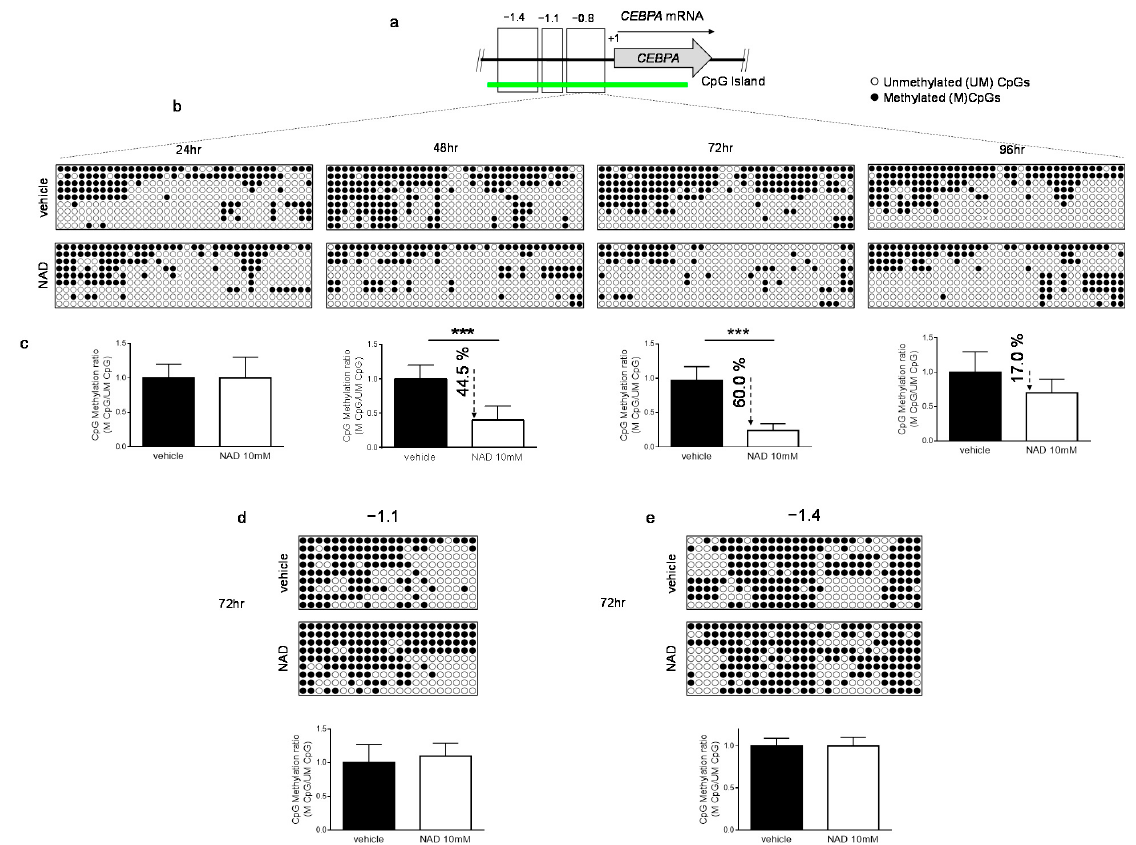
Figure 2. DNA methylation patterns of CEBPA upon NAD (10 mM) or vehicle treatment. ( a ) Schematic representation of CEBPA locus. The three regions analyzed in the promoter of CEBPA located at − 0.8 kb ( − 557; − 857), − 1.1 kb ( − 895; − 1.122) or − 1.4 kb ( − 1.120; − 1.473) from the TSS (+1) of the gene. ( b , c ) The methylation status of the distal promoter (the − 0.8 kb region) was assessed at the four indicated time points ( n = 9 clones). Lollipop graphs were generated using QUMA software. CpG methylation ratio, consisting of methylated CpGs divided by unmethylated CpGs, was calculated by QUMA software. ( d , e ) Methylation status of distal promoter I ( − 1.1 kb) and distal promoter II ( − 1.4 kb) 72 h upon NAD (10 mM) addition. Lollipop graphs were generated as described ( n = 9 clones). All bisulfite sequenced clones were analyzed by Fisher’s exact test, ***: p <